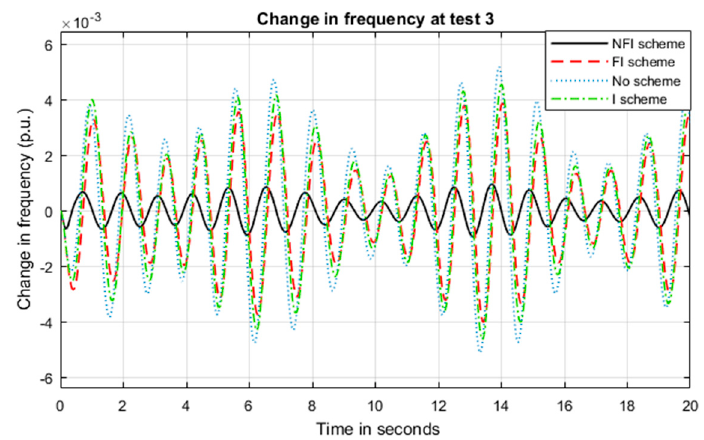
Figure 20. Change in frequency in test 3.